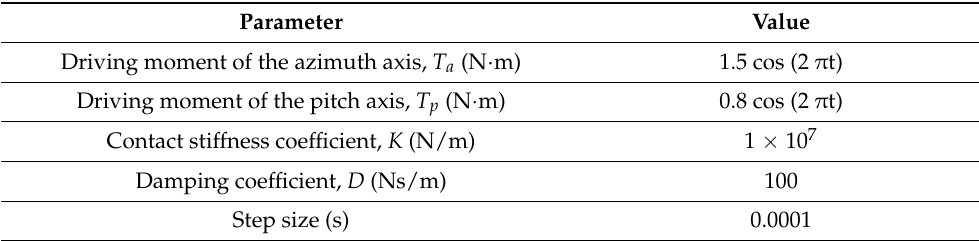
Table 2. Parameters used in the dynamic